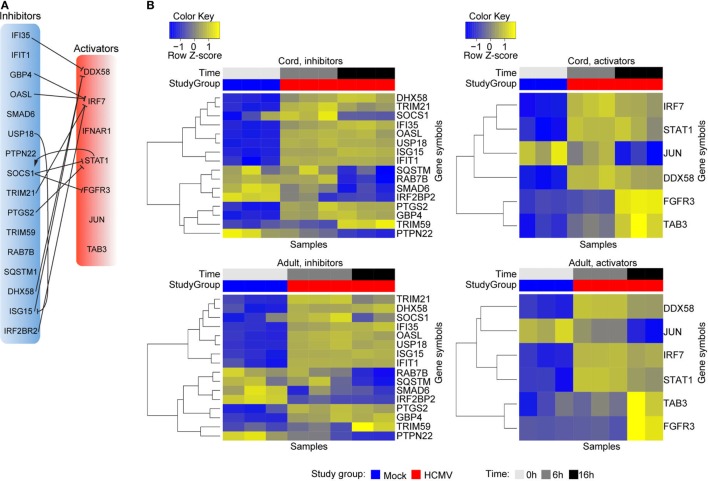
Expression analysis of immune activators and inhibitors reveal a complex regulation of the IFN response, centered on DDX58 and IRF7 activation. The immune inhibitors and immune activators that were identified among the significantly differentially expressed genes, in HCMV-infected cord and adult-derived DCs, and the relationship between them, is depicted in (A). Their per-gene normalized expression in mock-infected (0 h), 6 h, and 16 h postinfection is visualized using hierarchical clustering (B).